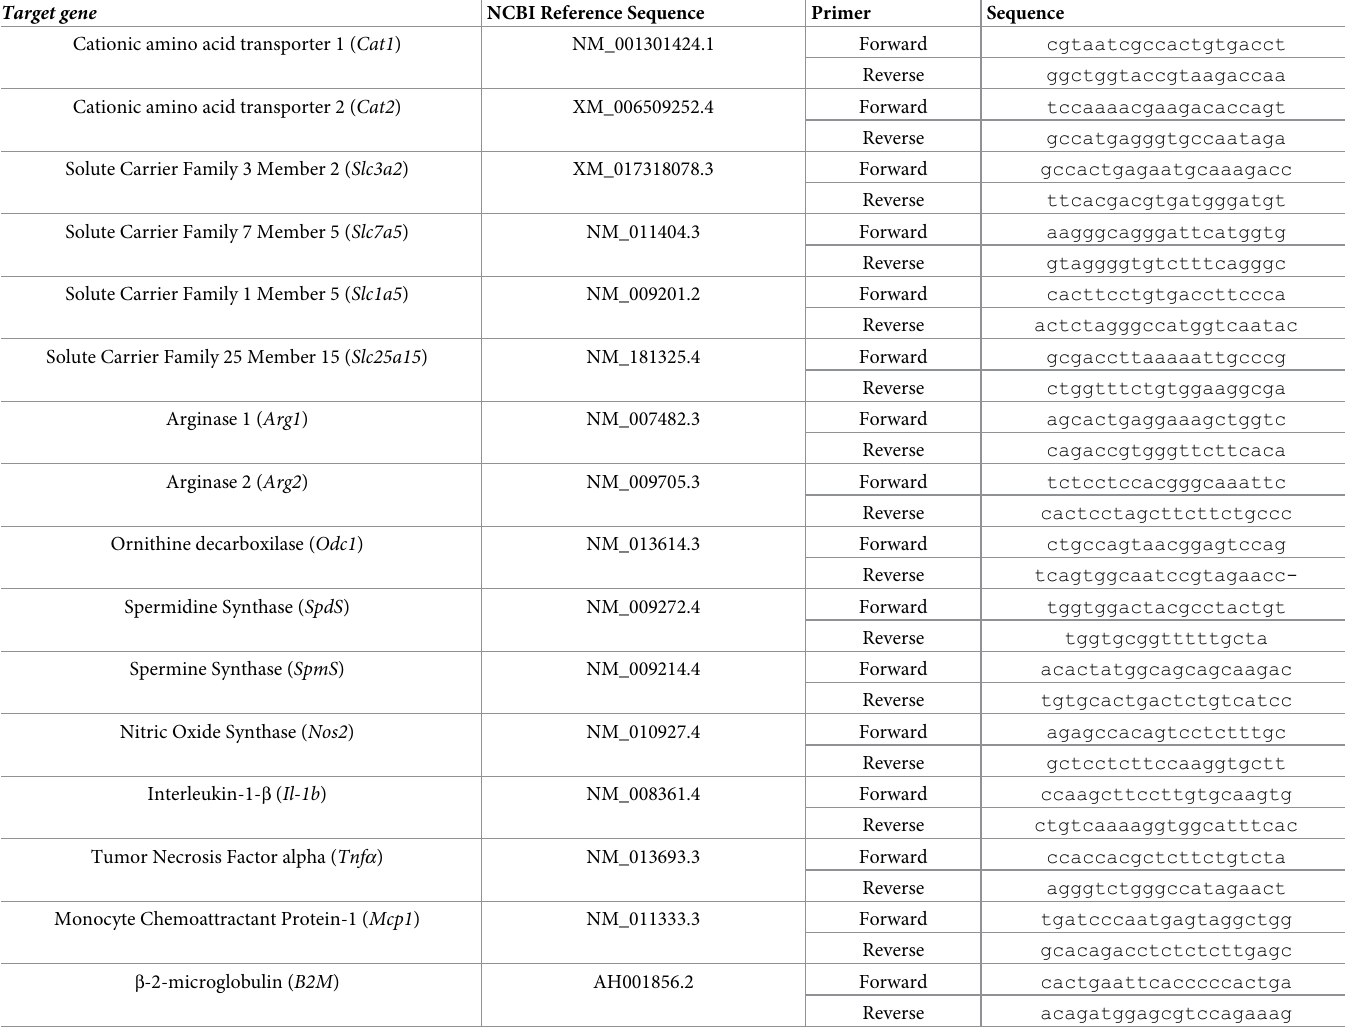
Table 1. List of oligonucleotide